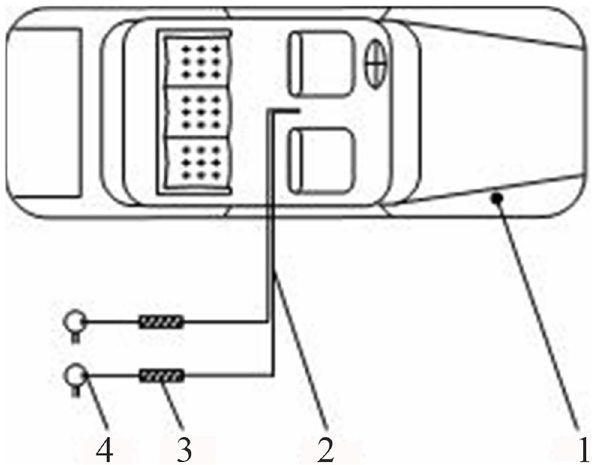
Fig 2. Schematic diagram of the experimental system. (1) tested car; (2) sampling catheter; (3) Tenax-TA tube; (4) sampling pump.